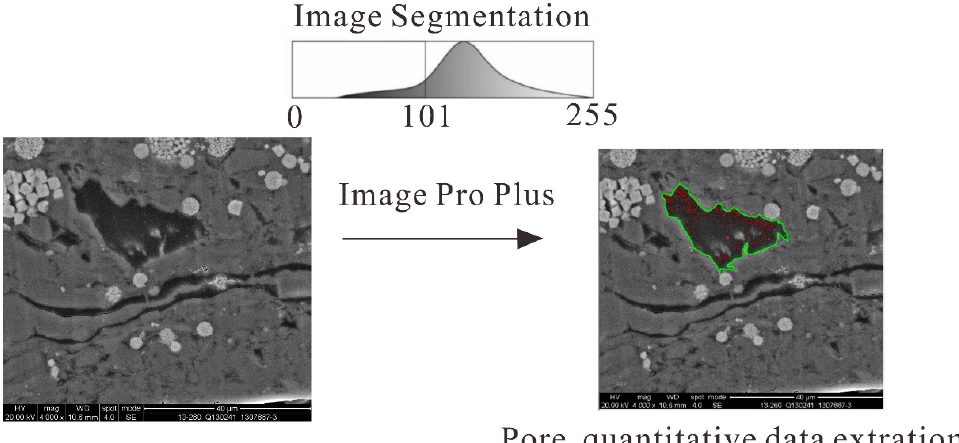
Figure 2. Pore extraction software flow.